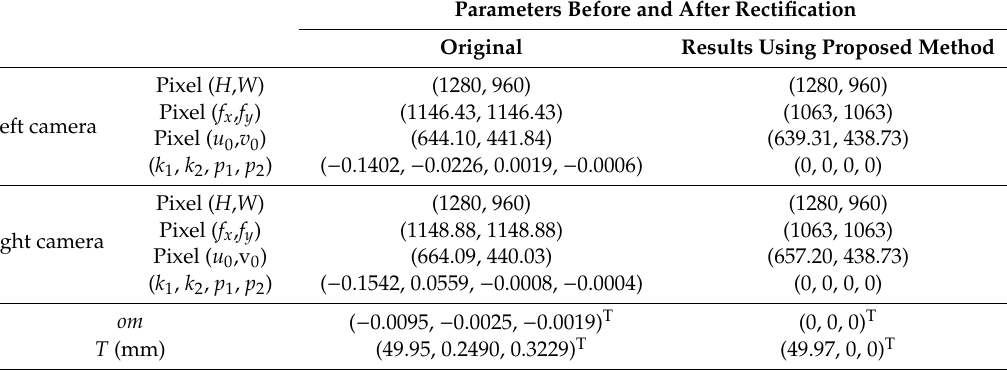
Table 1. Calibration results.